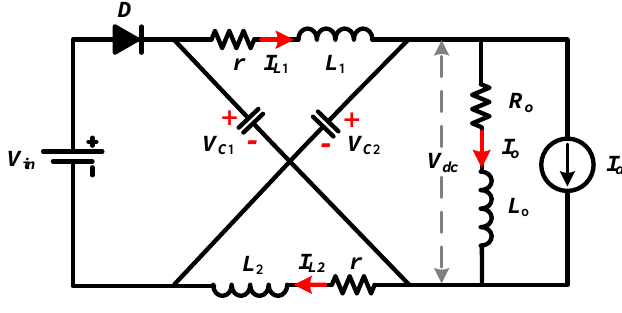
Figure 4. Current source model of network load